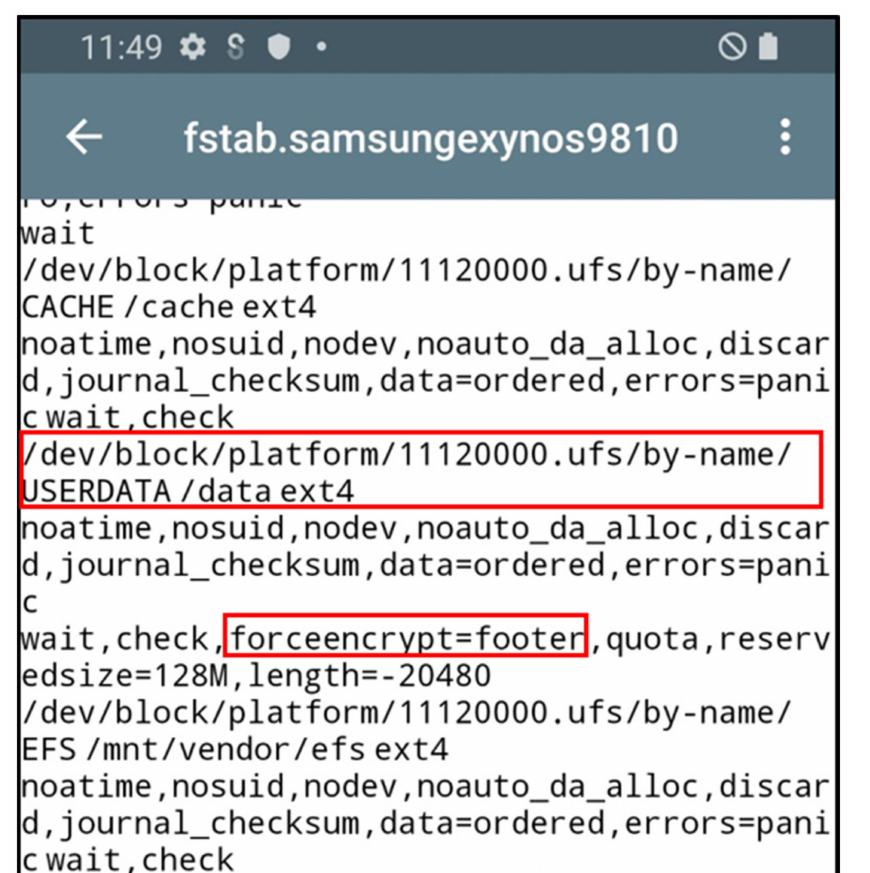
Figure 1. Galaxy S9+ TRIM function default value in fstab.samsungexynos9810